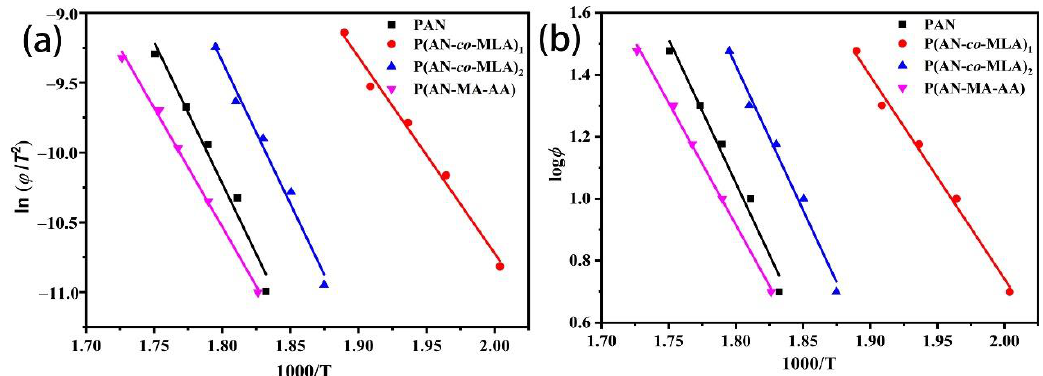
Figure 13. ( a ) Kissinger method and ( b ) Ozawa method used to quantify Ea of PAN, P (AN-MA-AA), and P (AN -co- MLA) with the feed ratio AN/MLA = 97/3 (wt/wt).